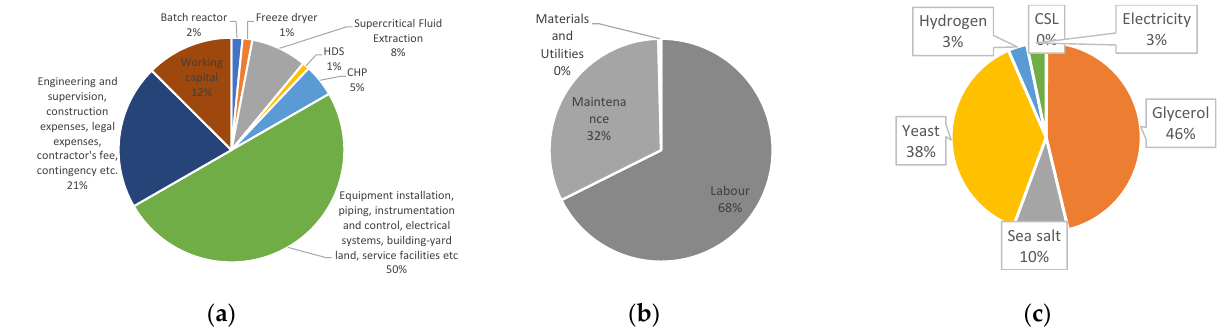
Figure 17. CAPEX ( a ), OPEX ( b ), and materials and utilities ( c ) for 0.14 g/L/h and 27 % oil content.